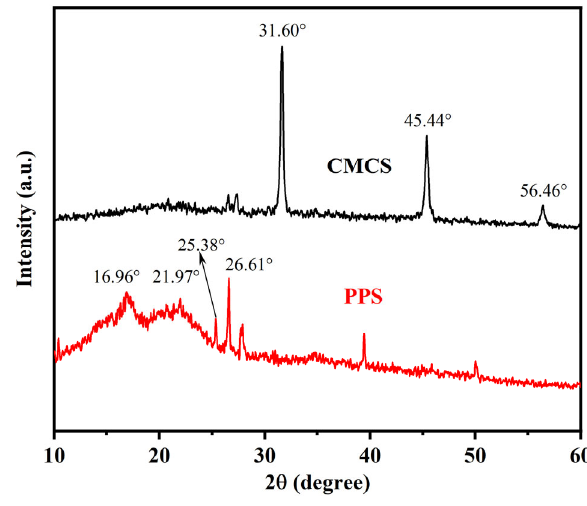
Figure 1. X-ray diffraction spectrograms of PPS and CMCS. Figure 1. X ‐ ray diffraction spectrograms of PPS and CMCS. Figure 1. X ‐ ray diffraction spectrograms of PPS and CMCS.